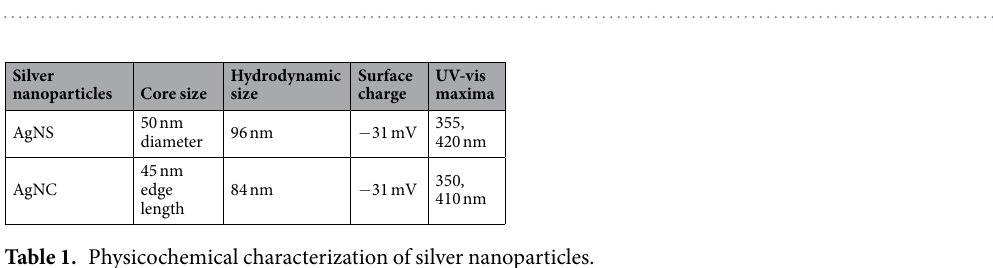
Figure 2. Hydrodynamic diameter changes for nanoparticles in different pH conditions: ( a ) AgNS and ( b )